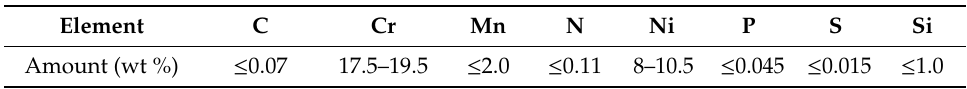
Table 1. Composition of 1.4301 (AISI 304)